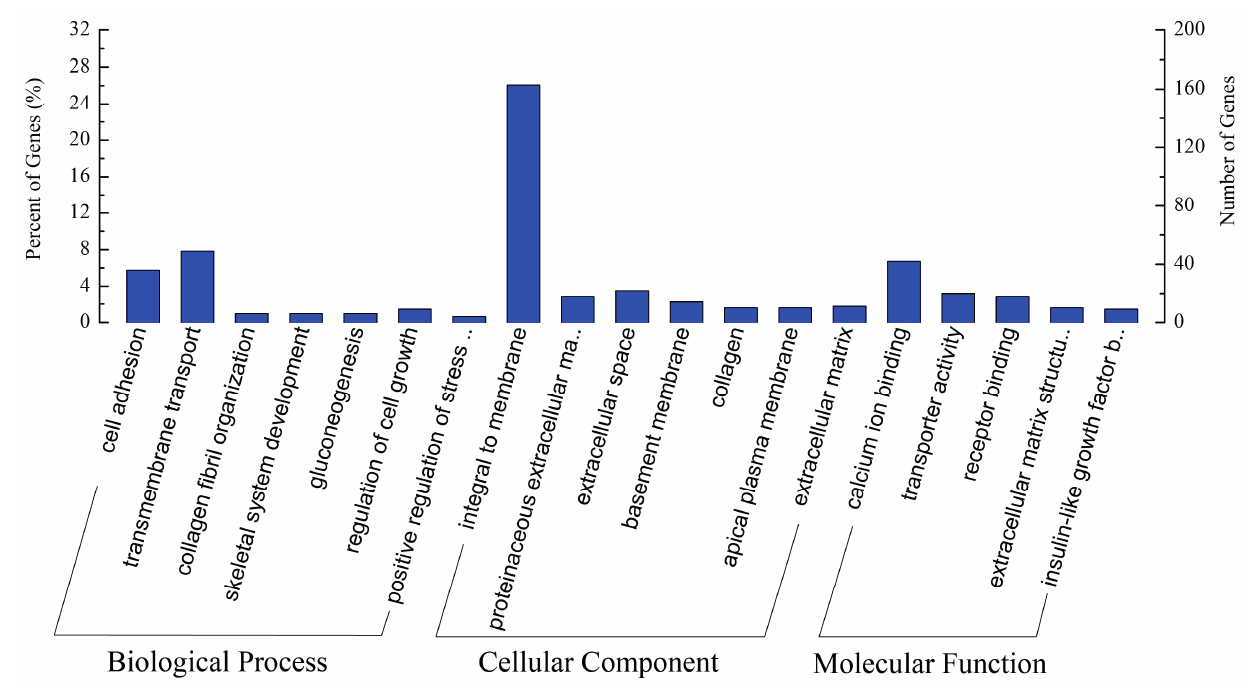
Figure 3. GO enrichment analysis of DEGs between NAS and NAA. GO: Gene Ontology; DEGs: differentially expressed genes; NAS: the East Asian finless porpoise; NAA: the Yangtze finless